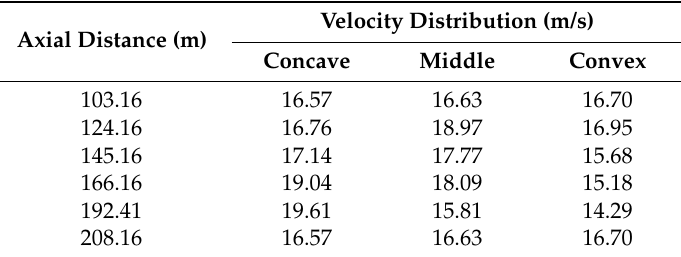
Table 3. The cross-sectional velocity distribution of the curved stepped spillway at a flow discharge rate of 272.0 m 3 /s of the